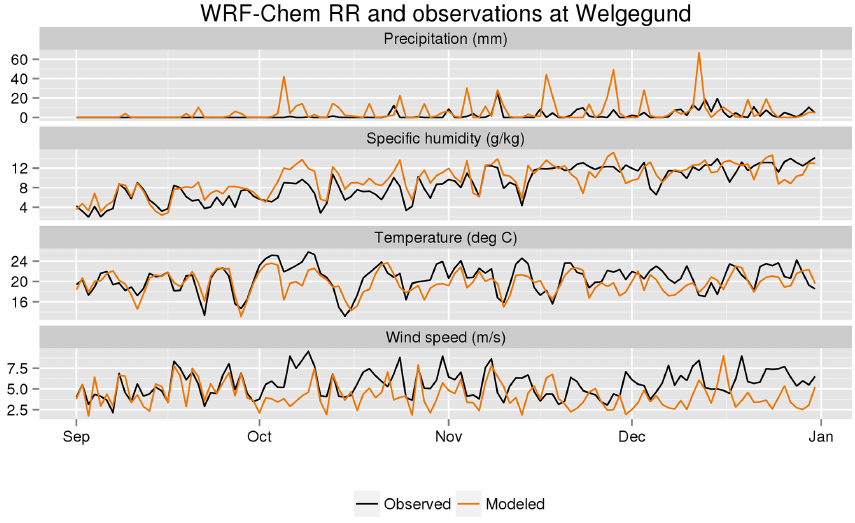
Figure 3. WRF-Chem model results of meteorological variables at Welgegund in comparison with Welgegund station measurements and precipitation satellite data (TRMM). Shown are daily means (daily sums in the case of